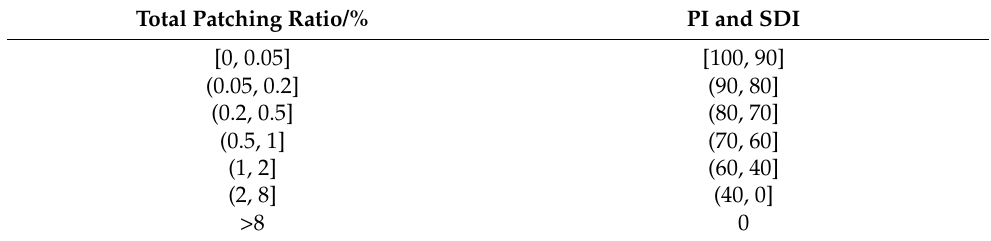
Table 5. Threshold of PI and SDI